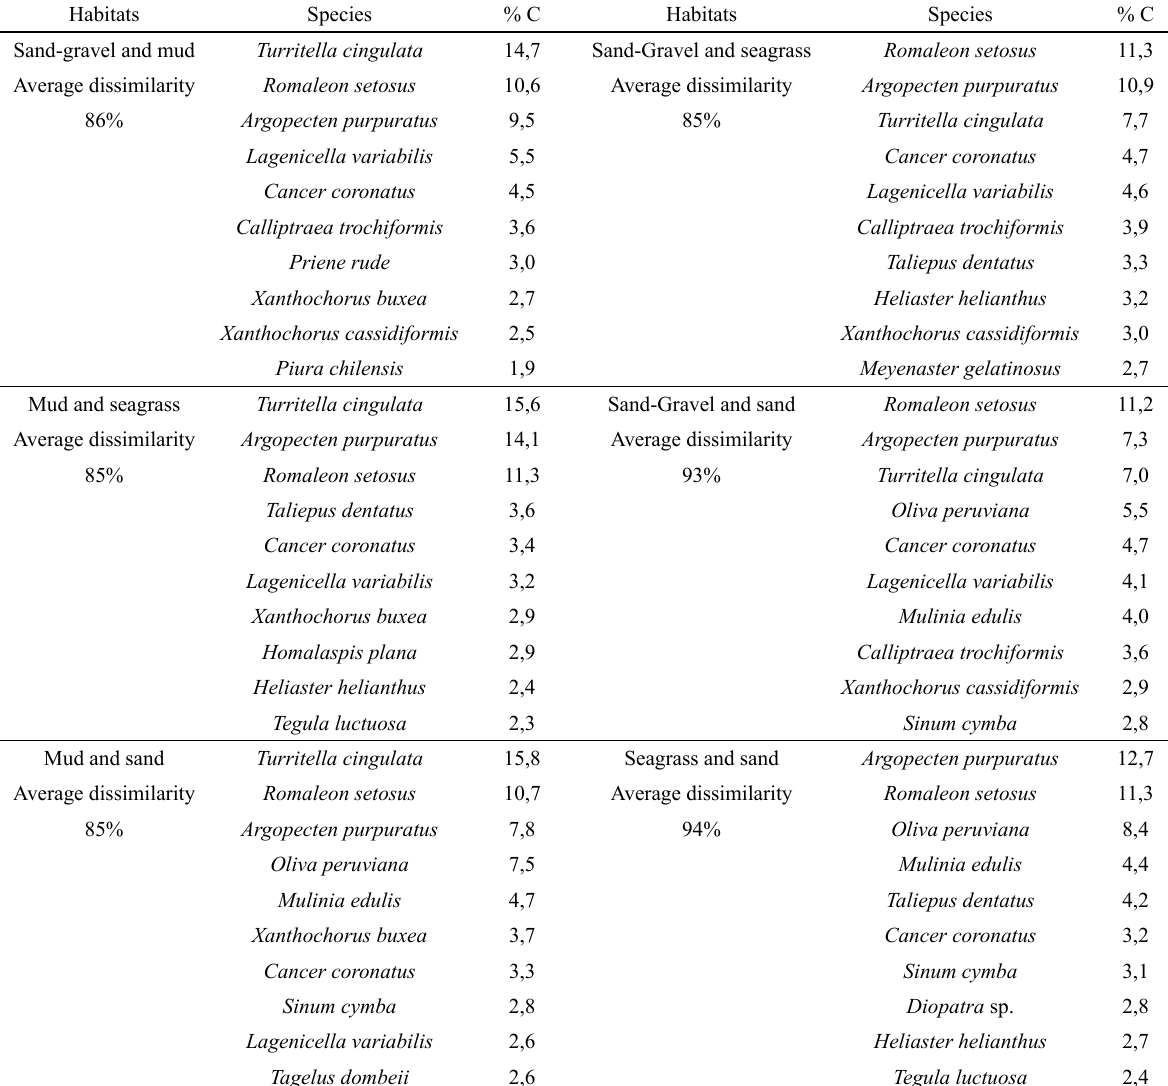
of contribution.